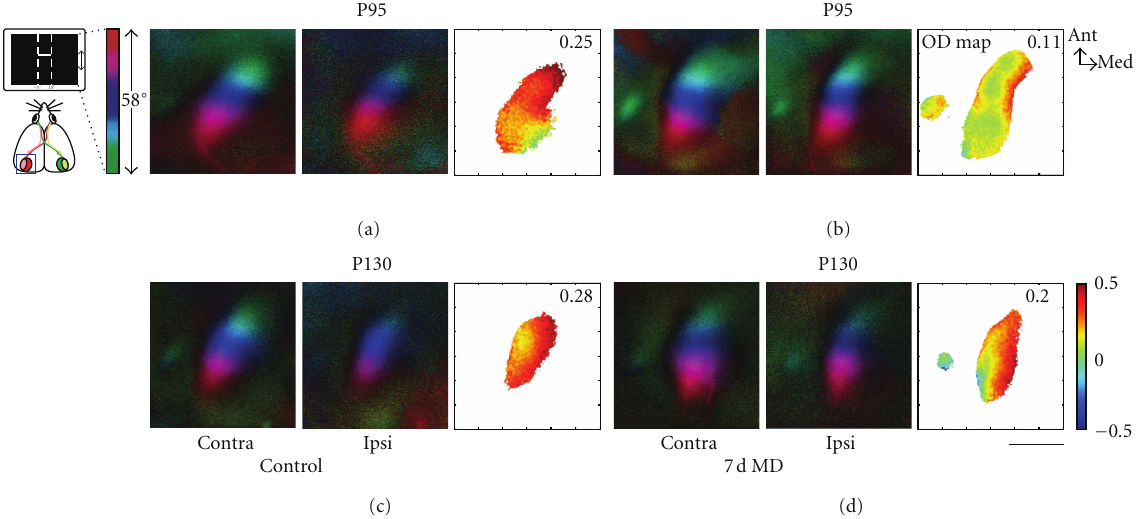
Figure 7: Adult ocular dominance plasticity ceases at postnatal day (P) 100. Retinotopic maps of the binocular visual cortex are shown. Elevation is colour coded according to the scheme on the left. Polar maps obtained by stimulation of the contralateral (contra) or ipsilateral (ipsi) eye are illustrated for four representative mice. Ocular dominance (OD) in the visual cortex is shown in the OD maps on the right, colour-coded according to the scheme on the right. In nondeprived control mice both before (a) and after (c) P100, the contralateral eye activates the cortex more strongly than the ipsilateral eye, which is reflected in warm-coloured OD maps. Seven days of monocular deprivation shift OD towards the ipsilateral eye in P95 animals ((b), colder colours of OD map), but have no such e ff ect in the P130 animal (d). Scale: